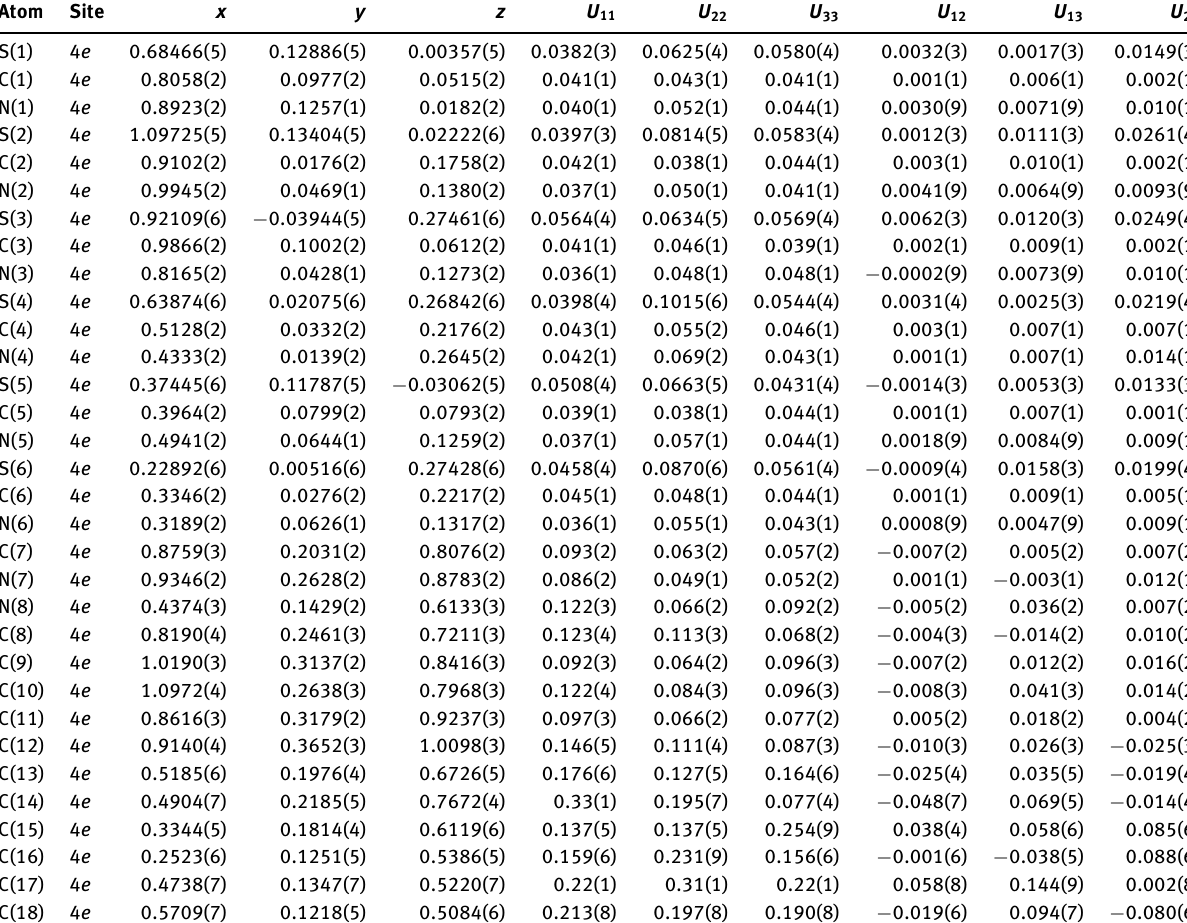
Table 3: Atomic displacement parameters (Å 2